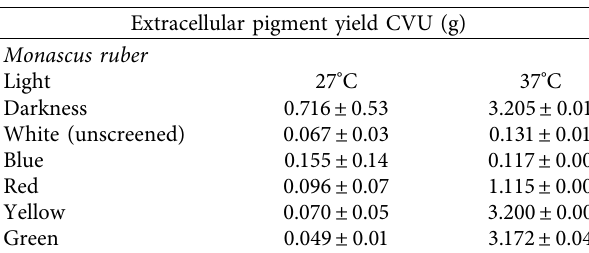
Table 1: Effect of an altered light source on extracellular pigment yield by Monascus ruber at 27 ° C and 37 ° C.